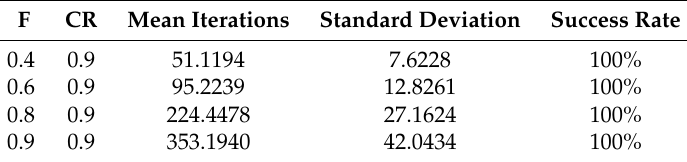
Figure 11. Objective value evolution for DE. Table 7. DE performance for n = 64.